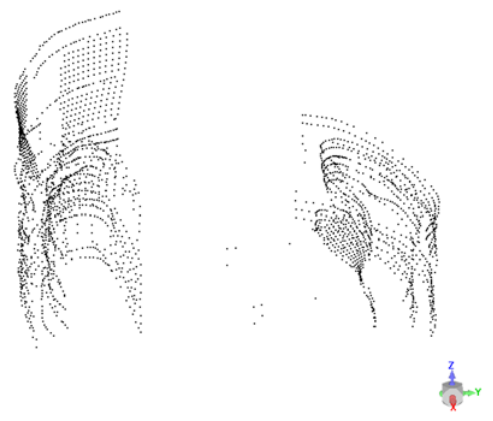
Figure 8: The 3D point cloud created